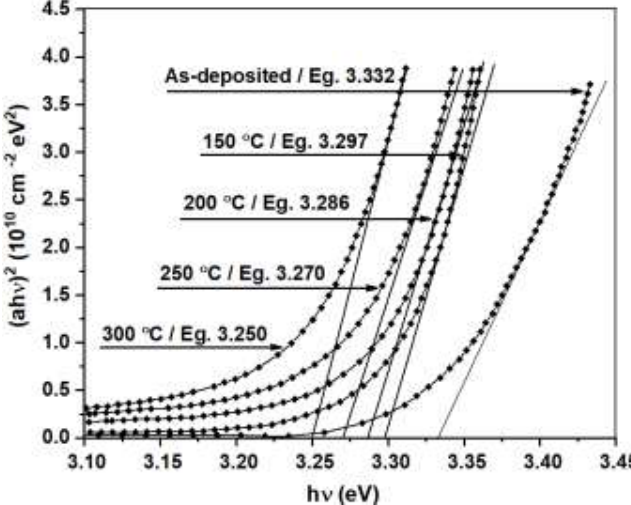
Figure 6: Determination of the ZnO thin film Band gap from the Urbach energy . Figure 6 ZnO thin film ( ahv ) and photon energy curve compared with ( hv ) at annealing temperatures 150 °C, 200 °C, 250 °C and 300 °C. The relationship between the bandgap and Urbach energy of ZnO thin film after annealing treatment show that the bandgap decreased with the annealing temperature. That confirms that as the annealing temperature increases, the film improvement increases, and defects decreased. The intercept of the absorption edge tangent on the abscissa is the optical energy gap. The annealed sample at 300 °C was the forbidden bandwidth Eg = 3.28 eV, which is consistent with the wurtzite